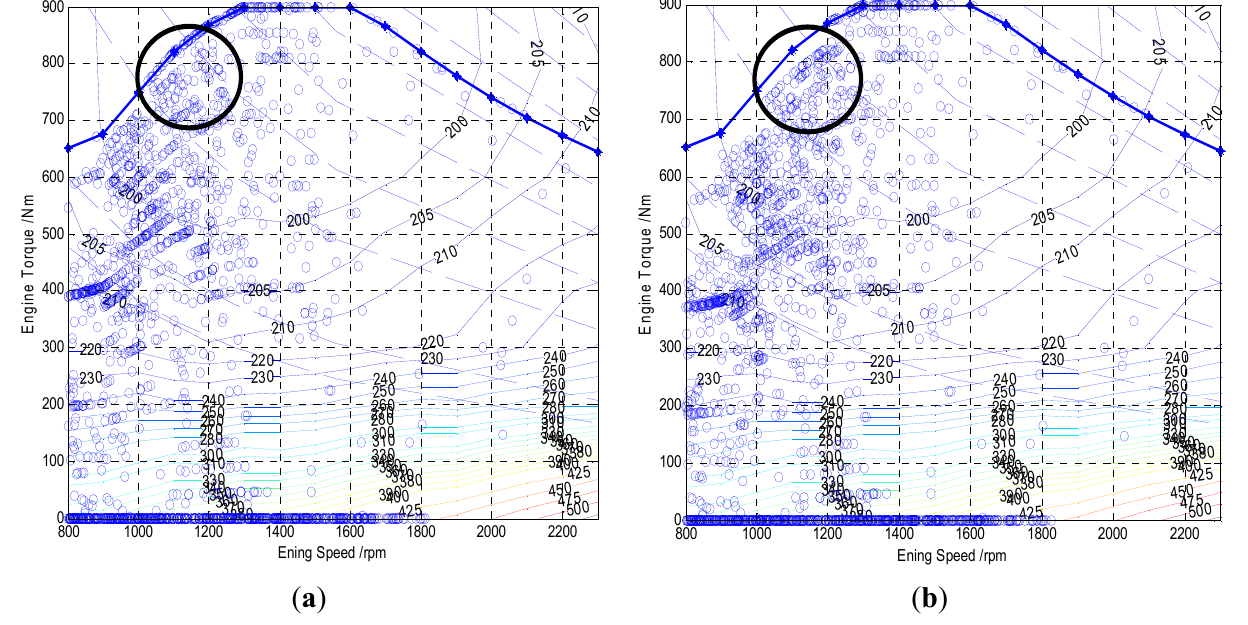
Figure 8. Work area of engine in DP and PMP. ( a ) Working zone of the engine in DP; ( b ) Working zone of the engine in